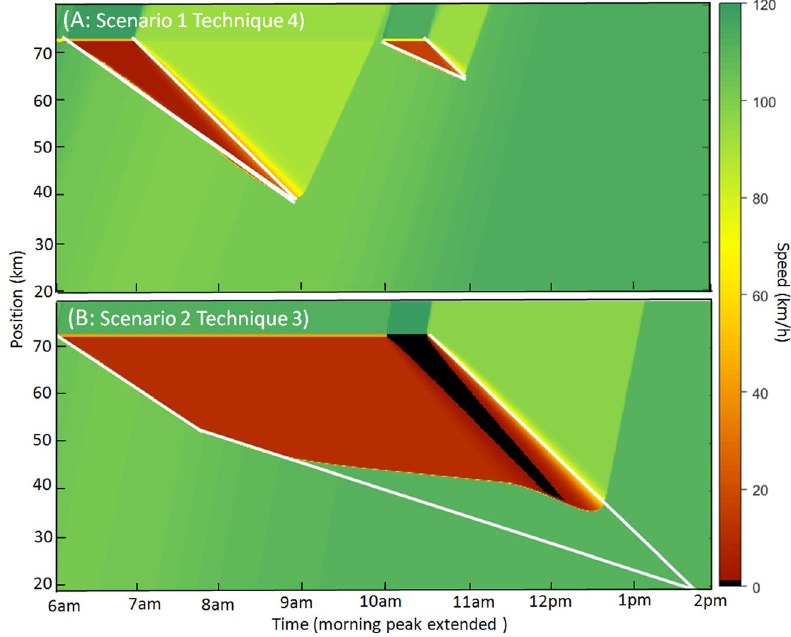
Fig. 9 Comparing traffic state estimations using CTM-v simula- tion and macroscopic queue modelling for cases with two scene management periods